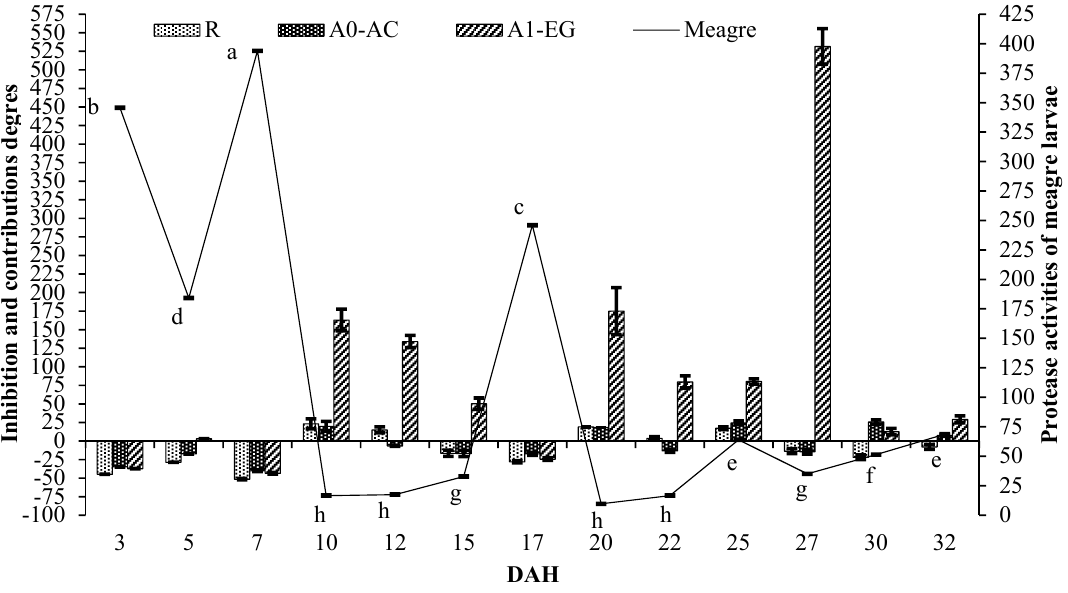
Figure 3. Protease activities of meagre larvae (U/mg protein, mean ± SE) ( p < 0.05) and inhibitions and contributions of live foods on protease activities of meagre larvae in 2014 (%, mean ± SE). Line—larva protease and bar—live food inhibition and contributions.